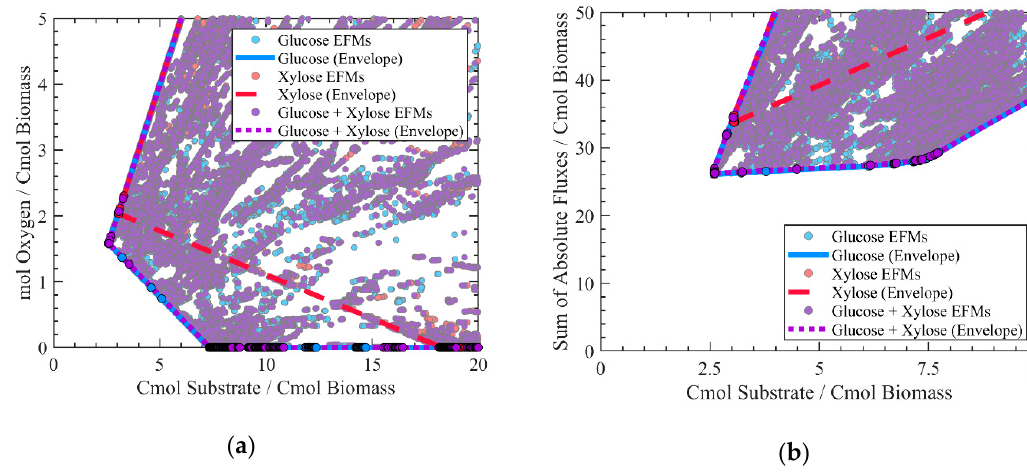
Figure 1. Glucose and xylose co-metabolism (glucose in blue; xylose in red; co-utilization in purple)— ( a ) oxygen cost as a function of carbon substrate cost (moles of oxygen versus moles of carbon consumed in substrate, normalized to moles of carbon in biomass); ( b ) pathway investment efficiency as a function of carbon substrate cost (sum of absolute fluxes per pathway versus moles of carbon consumed in substrate, normalized to moles of carbon in biomass). Each point on the plot represents the reaction ratio for an elementary flux mode (EFM) in the simulation; EFMs closer to the origin represent more efficient pathways.